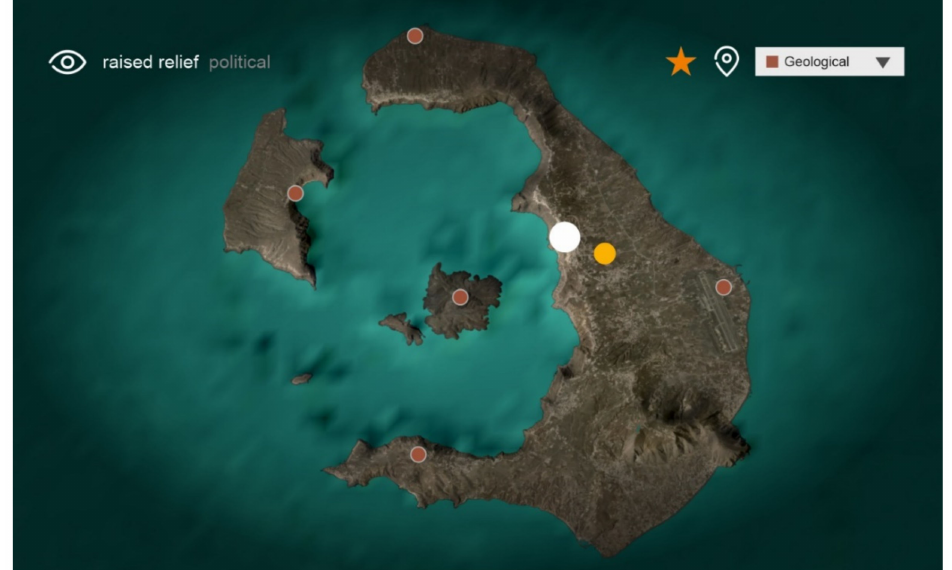
Figure 14. Top View of Santorini with marked Points of Interest (POIs) (White mark: City of Fira, Yellow mark: User’s location, Red mark: Points of geological interest. 3D Model has been produced by Up2metric VIRTUALDriver